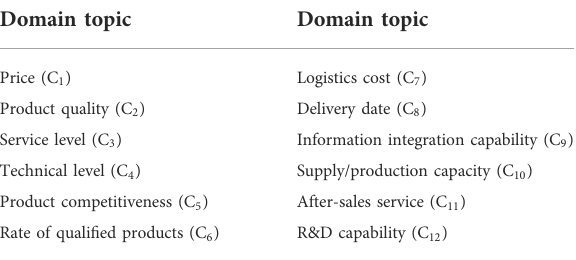
TABLE 4 Extracted domain topics based on LDA.